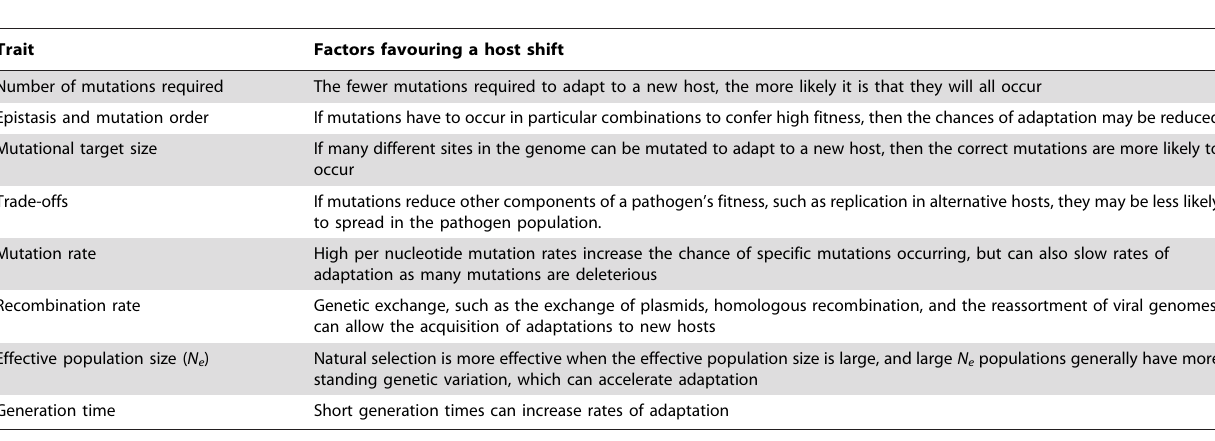
Table 1. Factors that evolutionary theory predicts will affect the likelihood that the correct set of mutations will arise to adapt a pathogen to a new host.